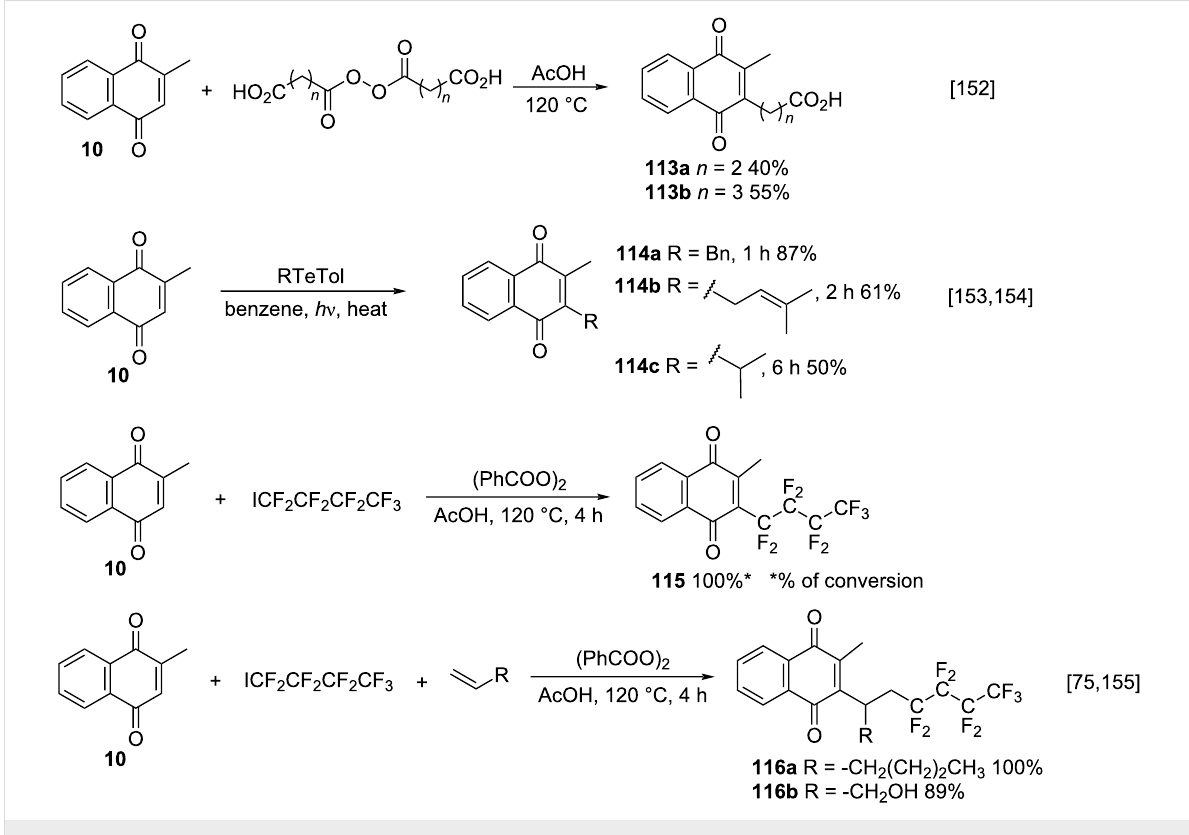
Scheme 38: Selected approaches to menadione